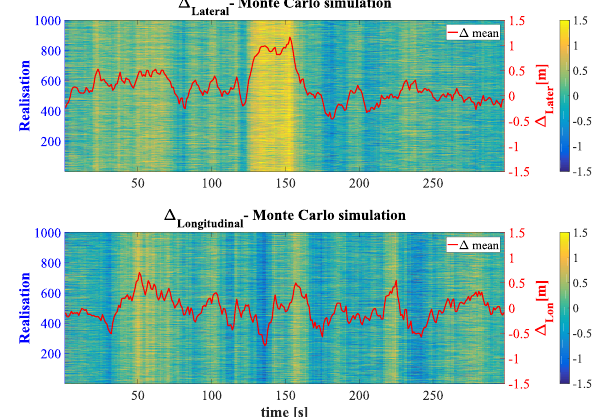
Figure 13. Deviation in Lateral (top panel) and longitudinal (bottom panel) directions. Vehicle 1 - Sensor setup 3